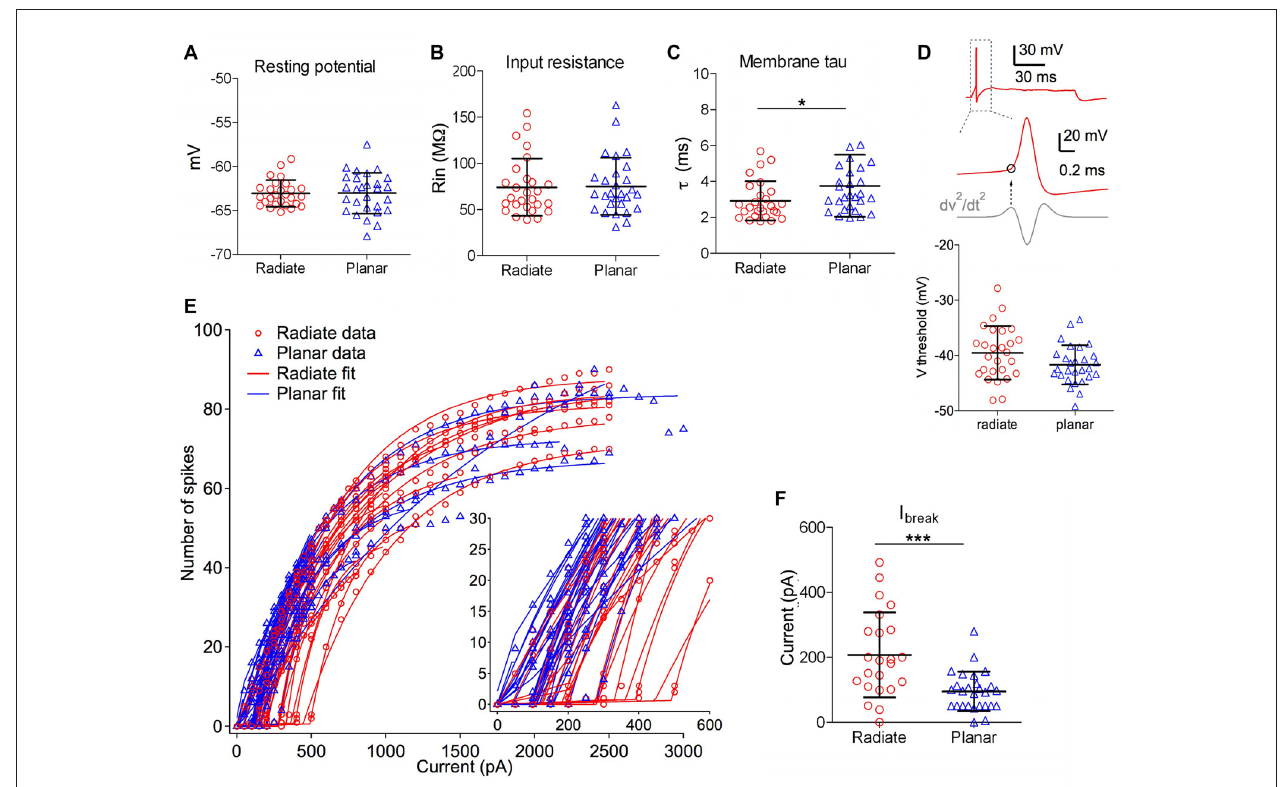
FIGURE 2 | Intrinsic membrane properties of radiate and planar cells. (A–C) Summary plot of resting membrane potential (A) , membrane input resistance (B) , and membrane time constant (C) from both cell types. (D) Summary plot of the threshold potential (V threshold ) from the first action potential evoked by minimum current injections (bottom panel). Top panel: example trace from a radiate neuron with an action potential evoked by the minimum current injection level. Middle panel: V threshold (marked as the circle) was measured as the membrane potential at which the second derivative (dV 2 /dt 2 ) was maximal during the rising phase of the action potential. (E) Current-spike relationship for all radiate and planar cells. Each line represents an individual cell. Points: data; lines: best fit from Equation 1. Inset: magnified view to show the break points (I break ) where the cells transition from no firing or phasic firing to tonic firing. (F) Summary of I break current levels for individual cells. ∗ p < 0.05; ∗∗∗ p < 0.001.